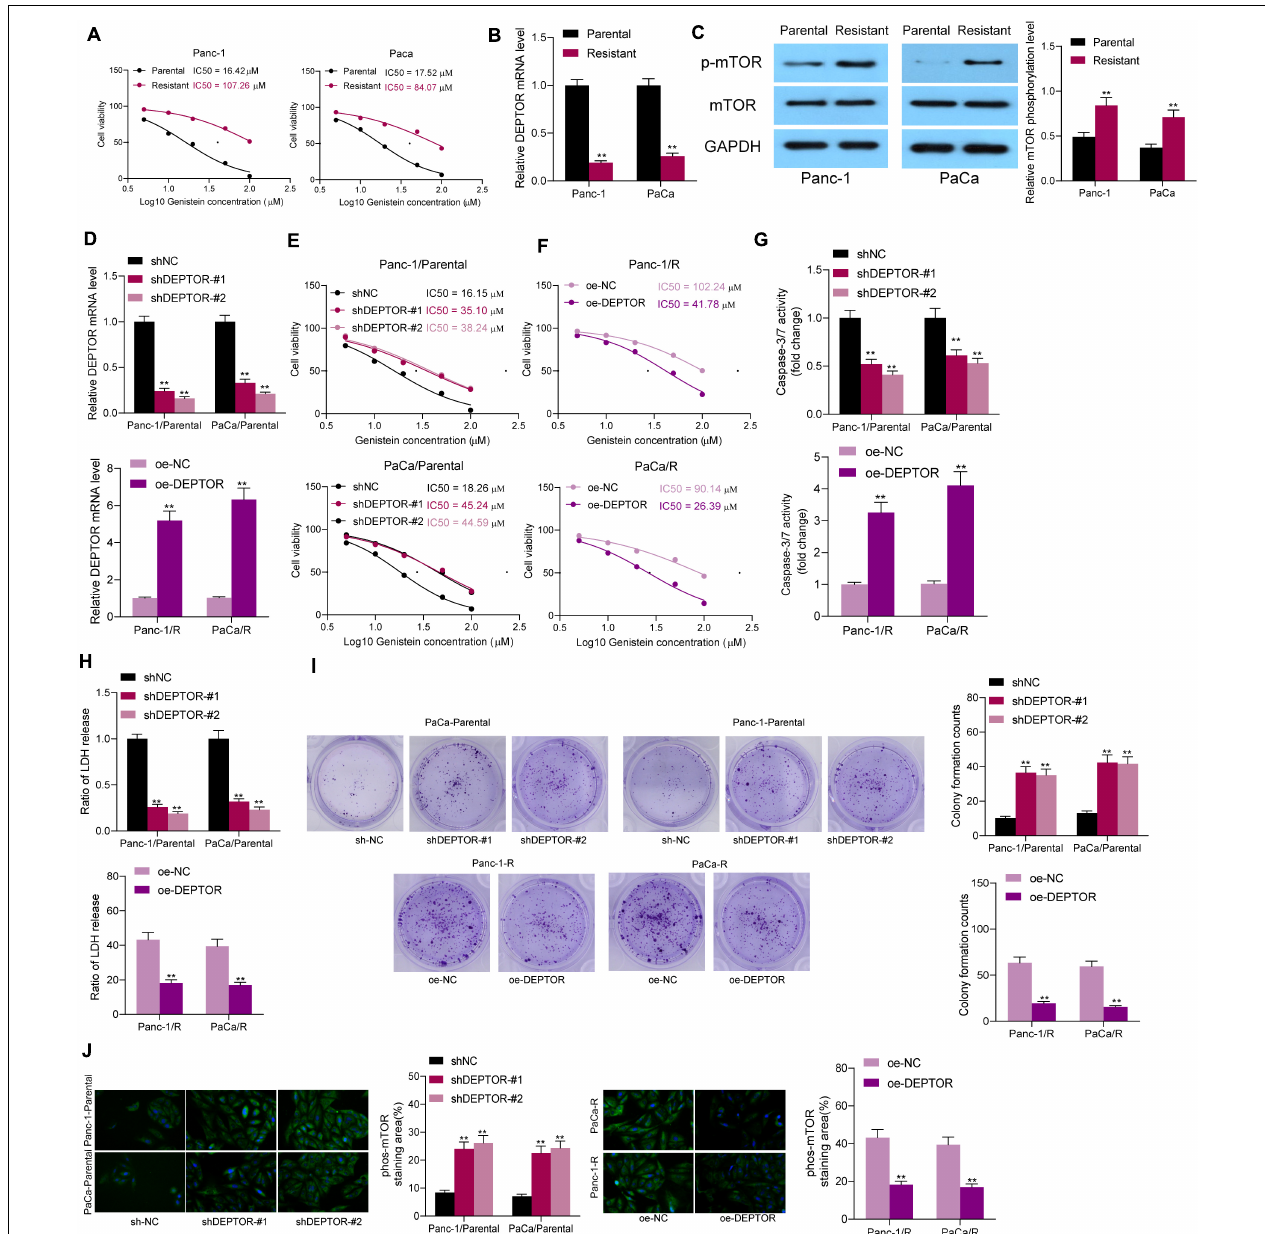
FIGURE 2 | Upregulation of DEPTOR promotes sensitivity of PC cells to genistein. (A) IC50 of genistein in parental and drug-resistant Panc-1 and PaCa cells determined using a CTG kit. (B) mRNA expression of DEPTOR in cells evaluated by reverse transcription quantitative polymerase chain reaction (RT-qPCR). (C) Phosphorylation of mTOR in Panc-1 and PaCa cells detected by Western blot assay. (D) DEPTOR expression in parental and genistein-resistant Panc-1 and PaCa cells after DEPTOR interventions examined by RT-qPCR. (E,F) IC50 of genistein in parental and genistein-resistant cells determined using a CTG kit. (G) Activity of caspase-3/7 in cells after 20 µ M genistein treatment determined using a caspase-3 kit. (H) Lactate dehydrogenase (LDH) release in cells after 20 µ M genistein treatment determined using an LDH release kit. (I) Viability of cells after 20 µ M genistein treatment evaluated using the colony formation assay. (J) mTOR phosphorylation in cells evaluated by Western blot analysis. Data were collected from three independent experiments and presented as mean ± SD. ** p < 0.01.